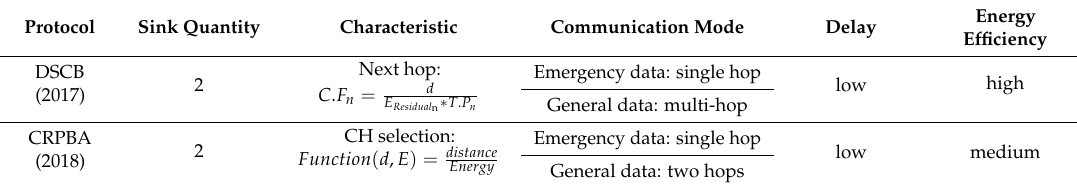
Table 5. Cluster-based routing protocols